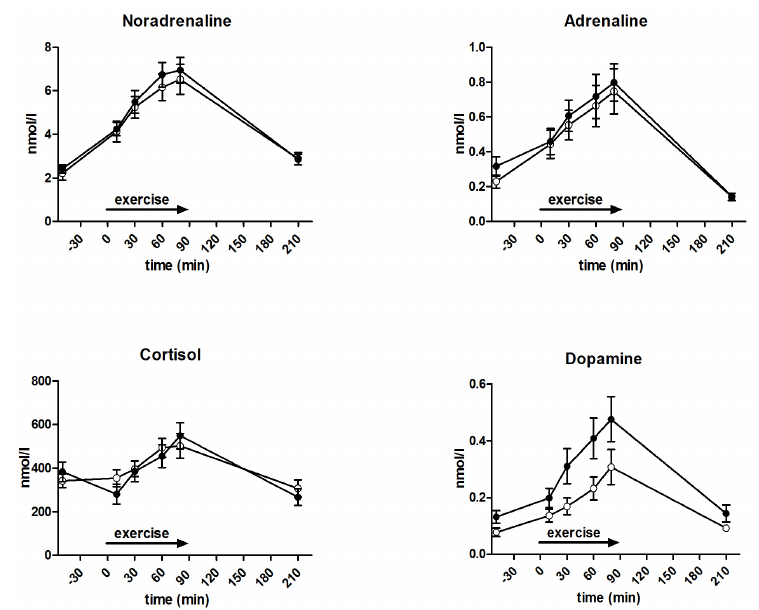
Figure 3. Measured hormones and metabolites during GLUFRU (black circle) and GLU (white circle). Clockwise from top left: lactate, p = 0.012; non ‐ esterified fatty acids (NEFAs), p = 0.43; growth hormone, p = 0.50; adrenaline, p = 0.39; dopamine, p = 0.037; cortisol, p = 0.54; noradrenaline, p = 0.45; glucagon, p = 0.16. Results are expressed as mean ± SEM.